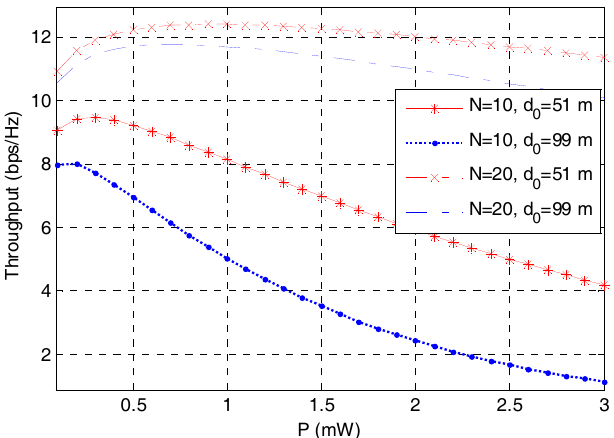
Figure 5. Throughput versus the threshold power P ( N = 15).